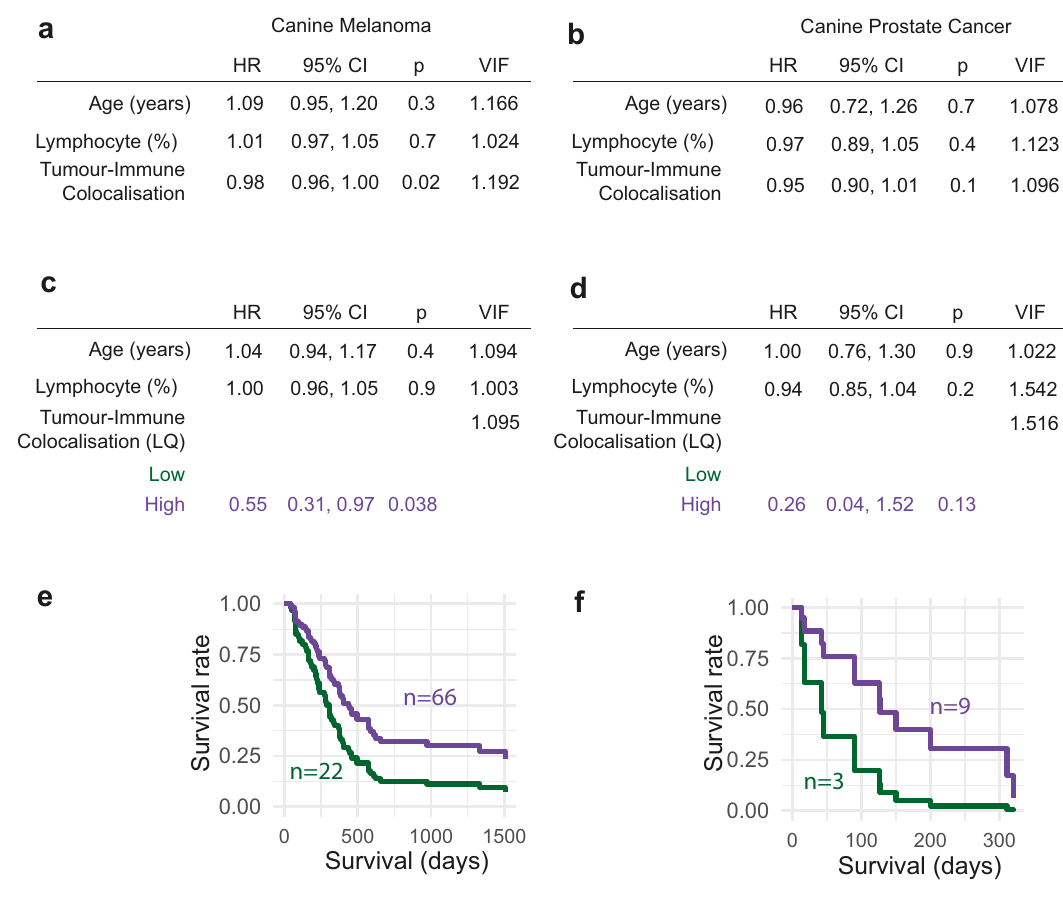
canine tumours. LQ, lower quartile, HR, hazard ratio, CI, con fi dence interval, VIF, variance in fl ation factor. Kaplan – Meier curves illustrating the difference in overall survival according to the colocalisation between cancer cells and lymphocytes, dichotomised into high (upper three quartiles) and low (lower quartile) groups, in melanoma ( e ), and prostate ( f ) canine tumours. Higher tumour-immune colocali- sation is associated with a better prognosis in melanoma patients. For prostate cancer, the same trend is observed (see Methods), although non-signi fi